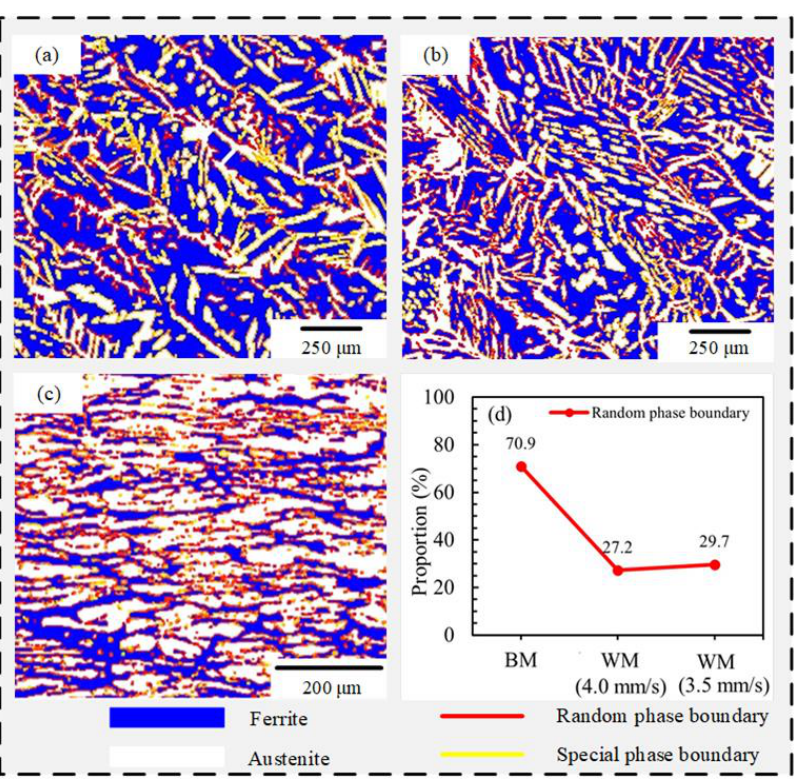
Figure 12. Orientations of the phase interfaces between ferrite and austenite in the WM and the BM. WM: ( a ) 4.0 mm/s, ( b ) 3.5 mm/s, ( c ) BM, ( d ) the proportion of the random phase boundary.